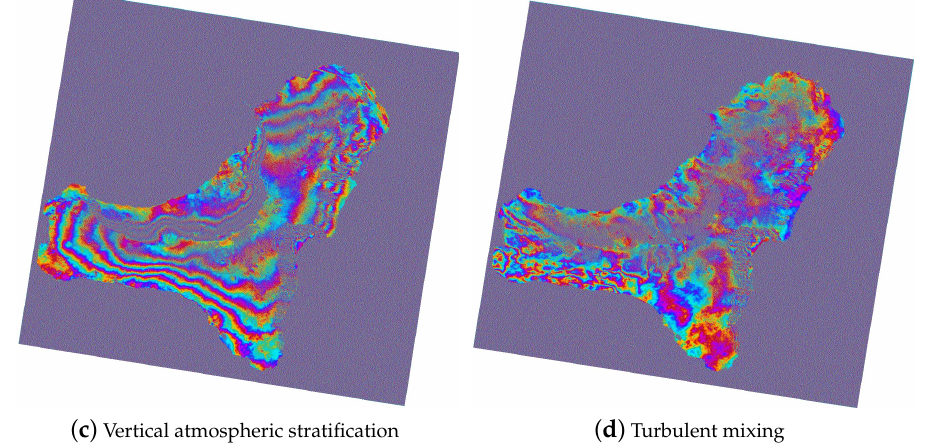
Figure 6. Tropospheric propagation delay effects on SAR interferometry due to vertical stratification and turbulent mixing: an example in the Hierro Island (Spain) using TerraSAR-X StripMap images. ( a ) Digital elevation model (DEM) of Hierro Island, with elevation varying from sea level (black) to about 1542 m (white). ( b ) SAR intensity image acquired on 10 October 2011. ( c ) Differential interferogram with master image acquired on 10 October 2011 and slave image on 21 October 2011 with an effective baseline of about 58 m. ( d ) Differential interferogram with master image acquired on 4 December 2011 and slave image on 15 December 2011 with an effective baseline of about 80 m. In ( c ) the interferometric phase is dominated by vertical stratification, whereas in ( d ) by turbulent mixing. Note that both are 11-day repeat pass